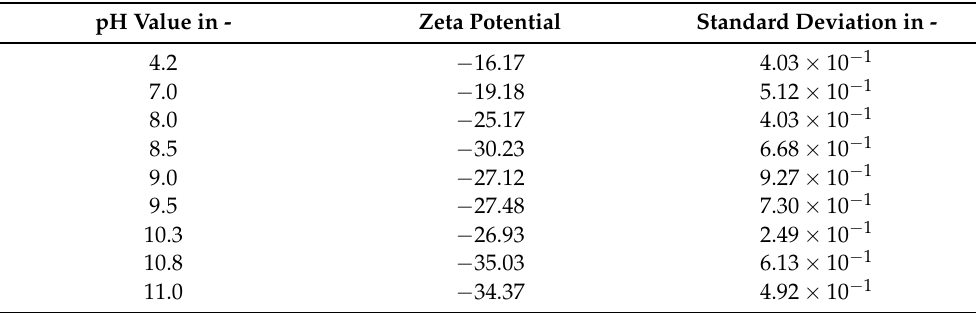
Table A6. Zeta potential values as a function of TX-100 content for a solution with 10 m% graphite nanoparticles.